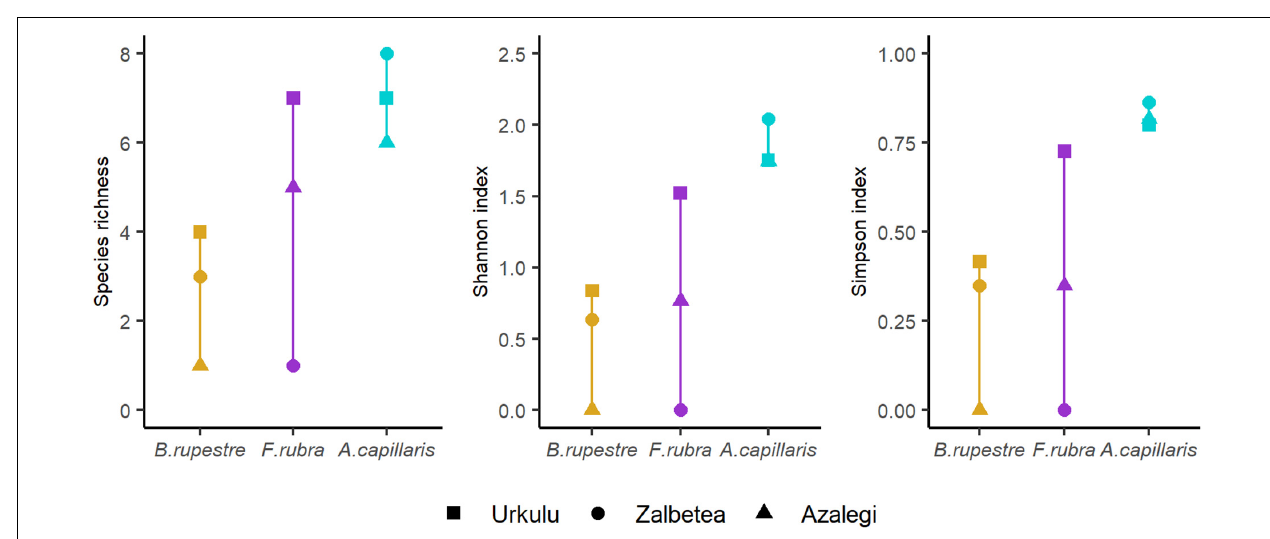
FIGURE 9 | Species richness and diversity indexes (Shannon, Simpson) of the mycobiome of shoots from three representative grasses of high-diversity grasslands from three locations.